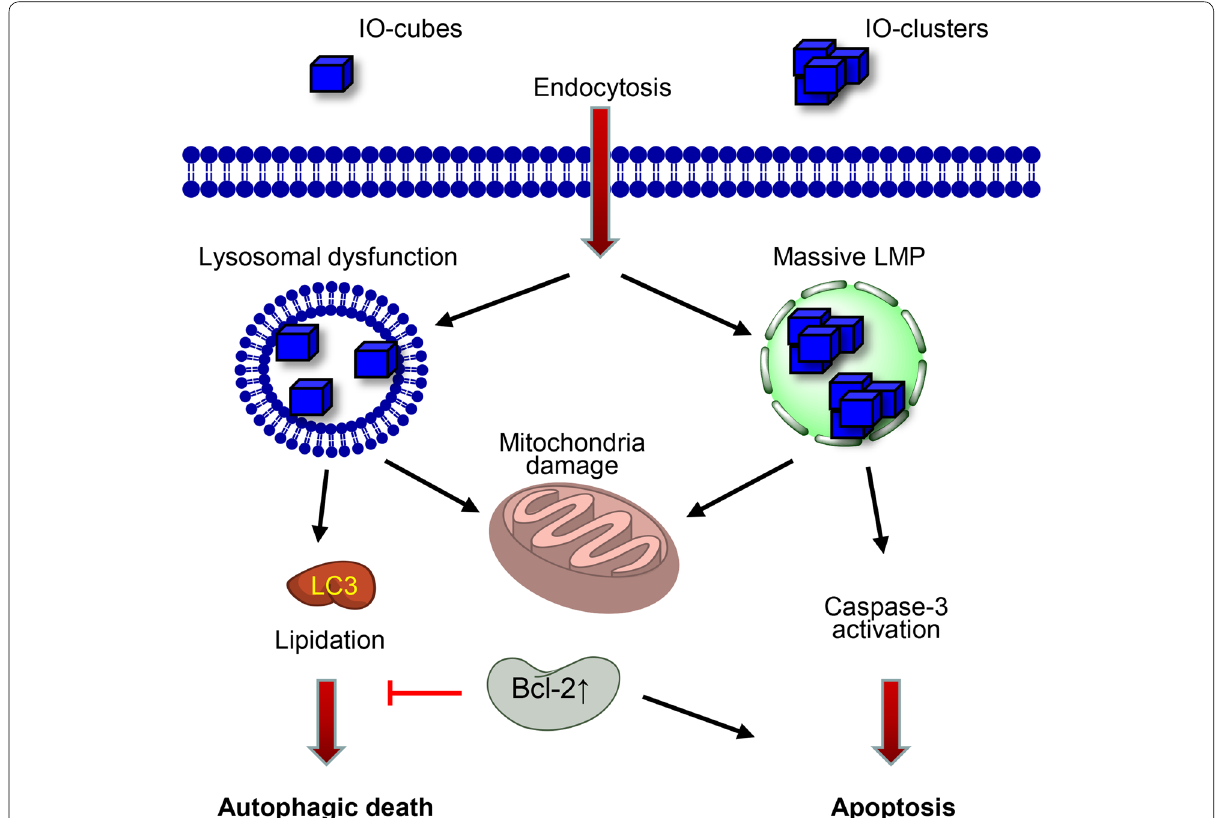
Fig. 8 Scheme of cell signaling activation after stimulation with IO-cubes or IO-clusters. LMP lysosomal membrane